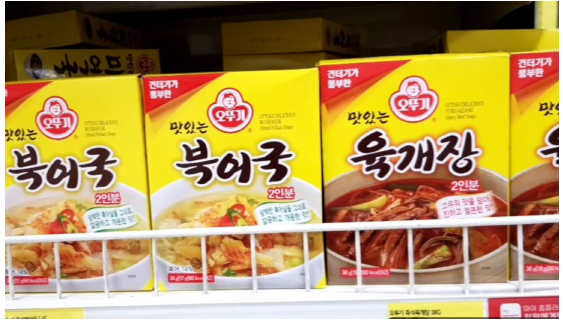
Figure 9. The guardrail of the shelf that hides some parts of the product